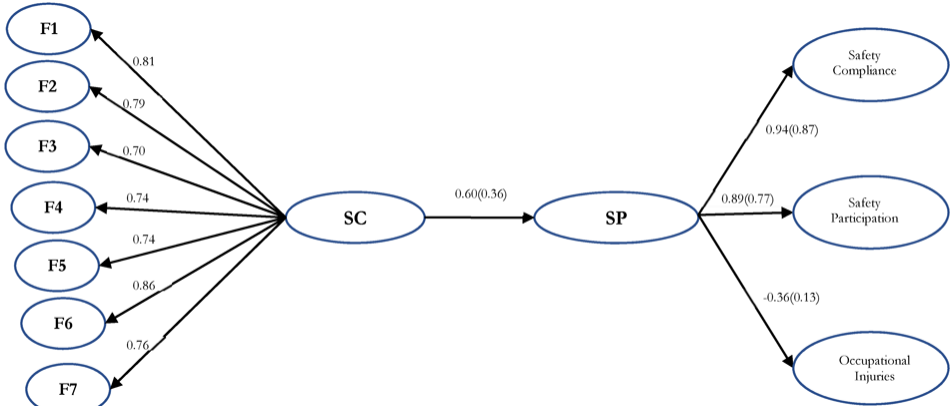
Figure 2 Reflective PLS-SEM Structural Model between Safety Climate and Safety Performance in Retrofitting Works. Note: values in the path indicate the loadings, values in parentheses represent R 2 of the latent variables (explained variance) Structural model loadings explained variance and effect size